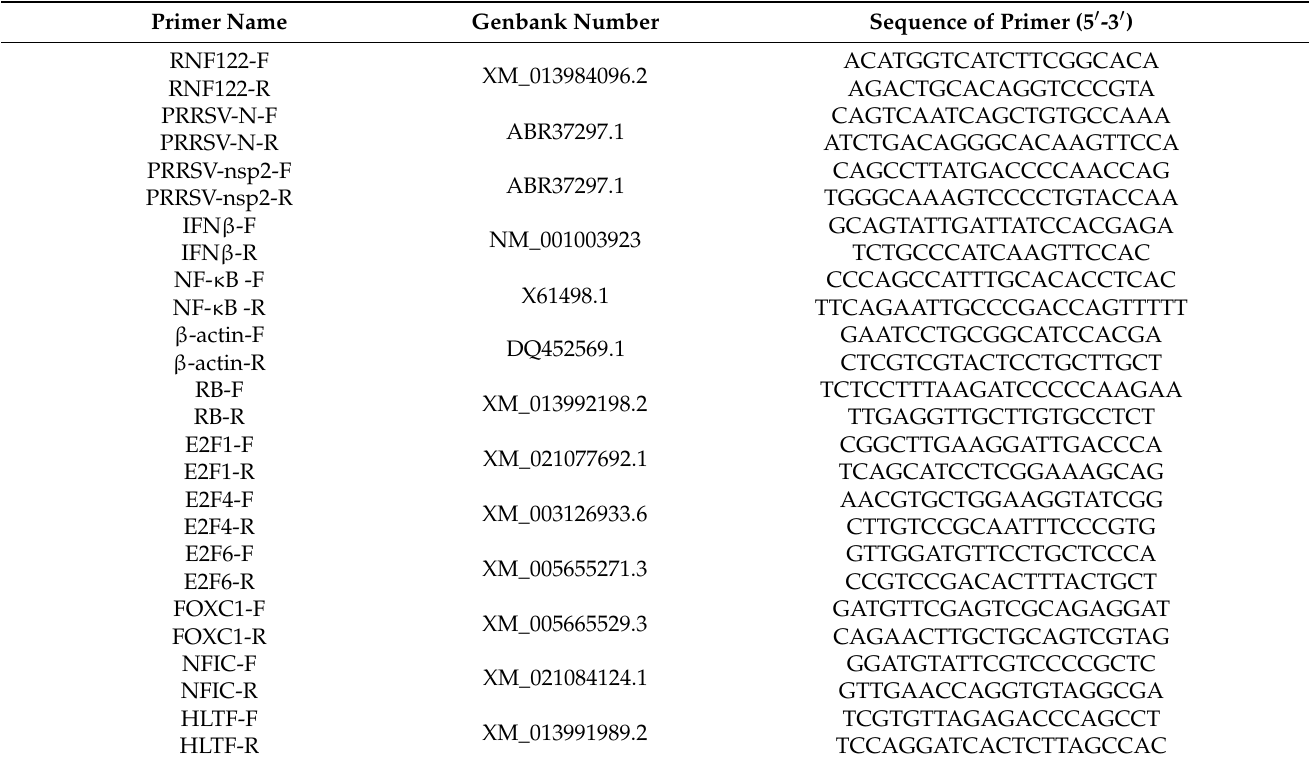
Table 4. The primers used for qRT-PCR